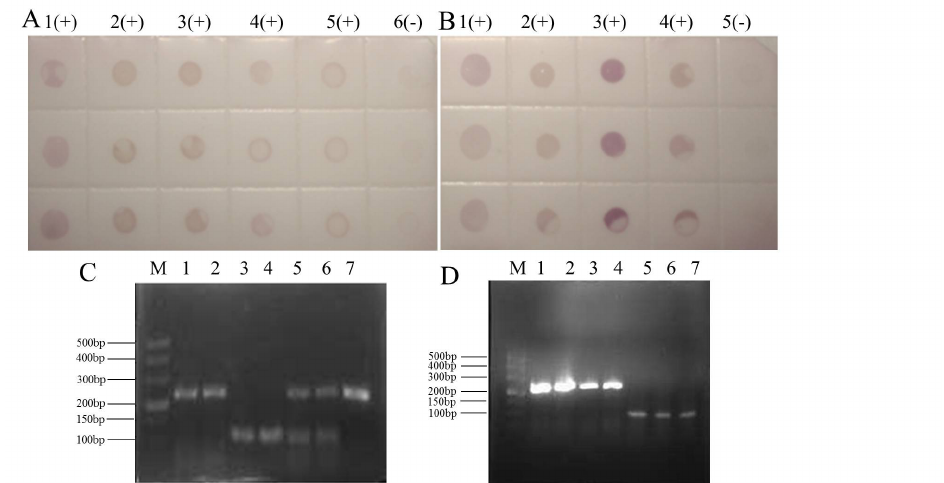
Figure 4. Positive controls were rice plants from Libo Guizhou province with confirmed SRBSDV infection. Negative controls were healthy rice plants grown in a greenhouse. (A) Dot-ELISA test (PVDF membrane) results of suspected rice plants from Shidian and Yuanjiang in Yunnan province. 1(+): Positive control. 2(+): Sample I from Shidian. 3(+): Sample II from Shidian. 4(+): Sample I from Yuanjiang. 5(+): Sample II from Yuanjiang. 6(-): Negative control. (B) Dot-ELISA test (PVDF membrane) results of suspected rice plants from Malipo Yunnan province. 1(+): Positive control. 2(+): Sample I. 3(+): Sample II. 4(+): Sample III. 5(-): Negative control. (C) One Step RT-PCR test results of suspected rice plants from Shidian and Yuanjiang. M: M, DL 500 bp DNA marker. 1: S10 gene amplification of rice sample I from Yuanjiang. 2: S10 gene amplification of rice sample IV from Shidian. 3: Reference gene amplification of rice sample I from Yuanjiang. 4: Reference gene amplification of rice sample IV from Shidian. 5: Multiple PCR of sample I from Yuanjiang. 6: Multiple PCR of sample IV from Shidian. 7: S10 gene amplification of positive sample. (D) One Step RT-PCR test results of suspected rice plants from Malipo. M: M, DL 500 bp DNA marker. 1: S10 gene amplification of rice sample I. 2: S10 gene amplification of rice sample II. 3: S10 gene amplification of rice sample III. 4: Positive control. 5: Reference gene amplification of rice sample I. 6: Reference gene amplification of rice sample II. 7: Reference gene amplification of rice sample